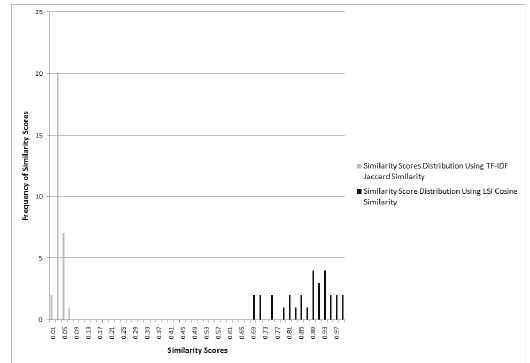
Fig. 14. Similarity score distribution TF-IDF Jaccard vs. LSI Co-